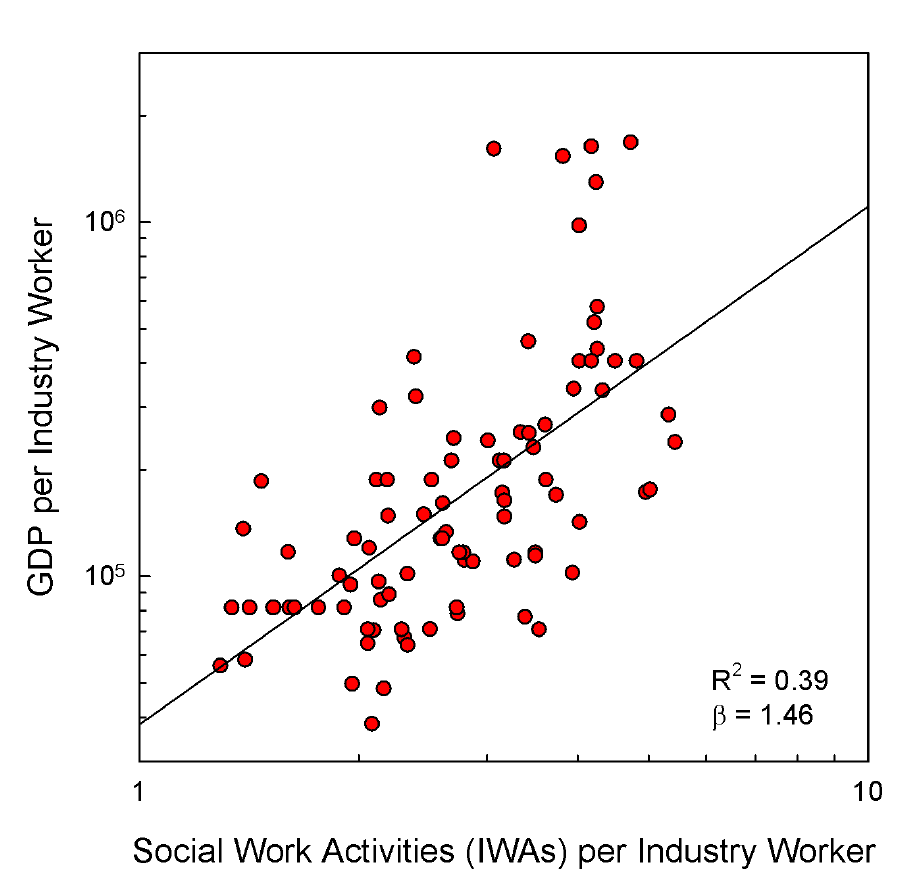
Figure 1. Power-law relationship between GDP and socialness. Both axes are logarithmic. Each dot represents an individual industry for which 2018 GDP and employment data are available ( N =